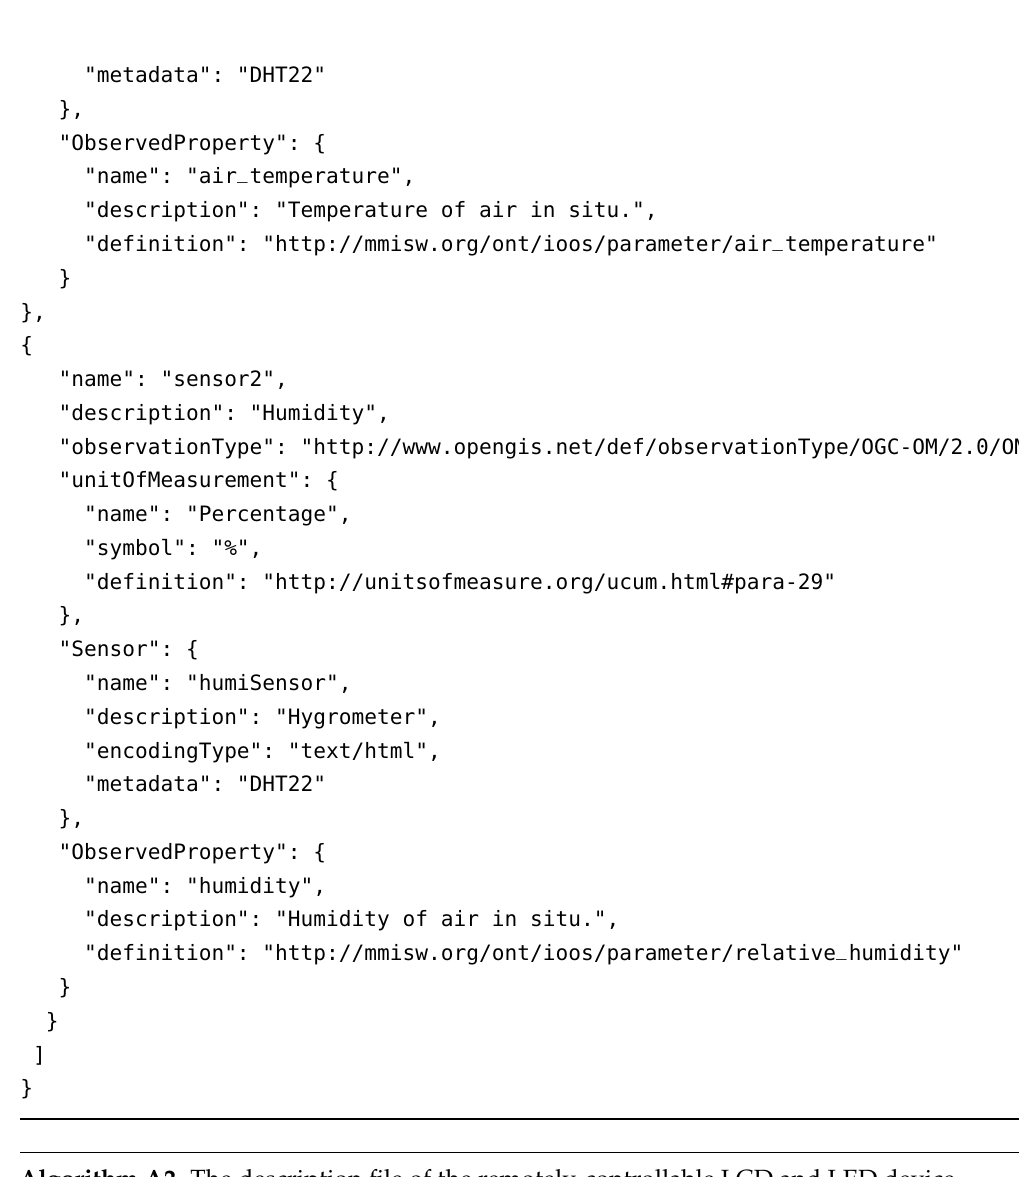
Algorithm A2. The description file of the remotely-controllable LCD and LED device.